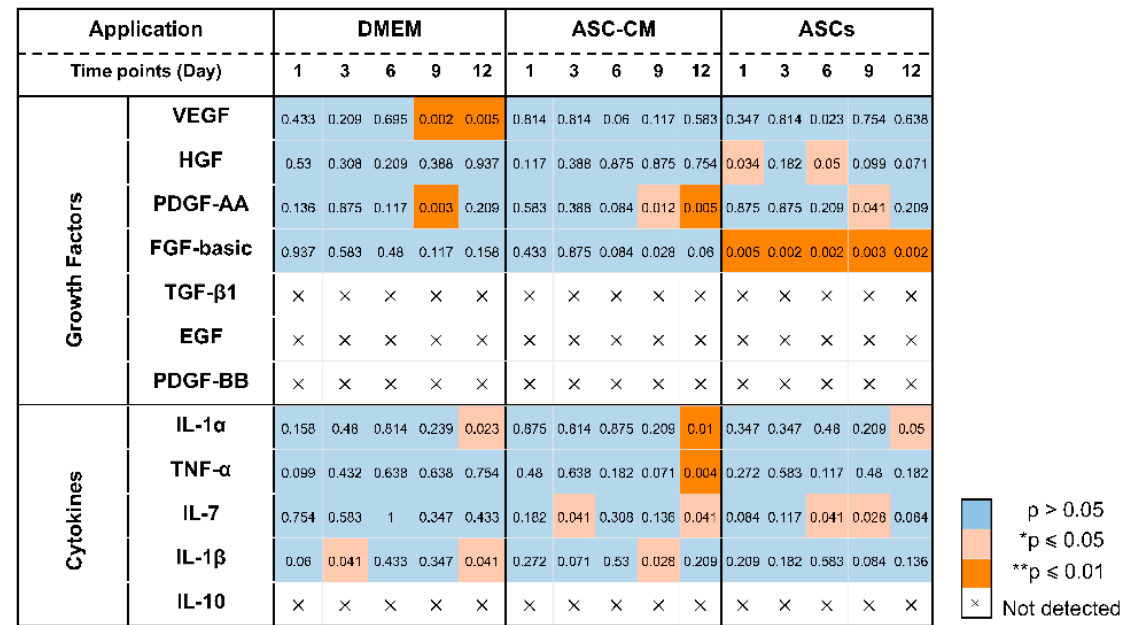
Figure 10. Visualization of statistically significant differences between treated samples and controls in wound extracts.